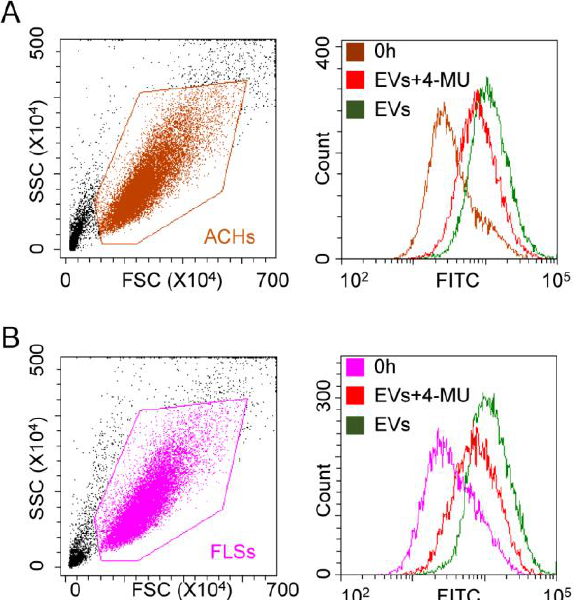
Figure 6. HA removal effect on ASC-EV interaction with ACHs and FLSs in 2D. ( A , B ) Cytograms showing fluorescence at time 0 and after 24 h for both ACHs and FLSs incubated with ASC-EVs, in presence and absence of HA-synthesis inhibitor 4-MU. HA removal reduces fluorescence increase at 24 h. 4-MU treated samples at time 0 are not shown for clarity, since no differences with control samples at time 0 emerged. One representative donor is shown.